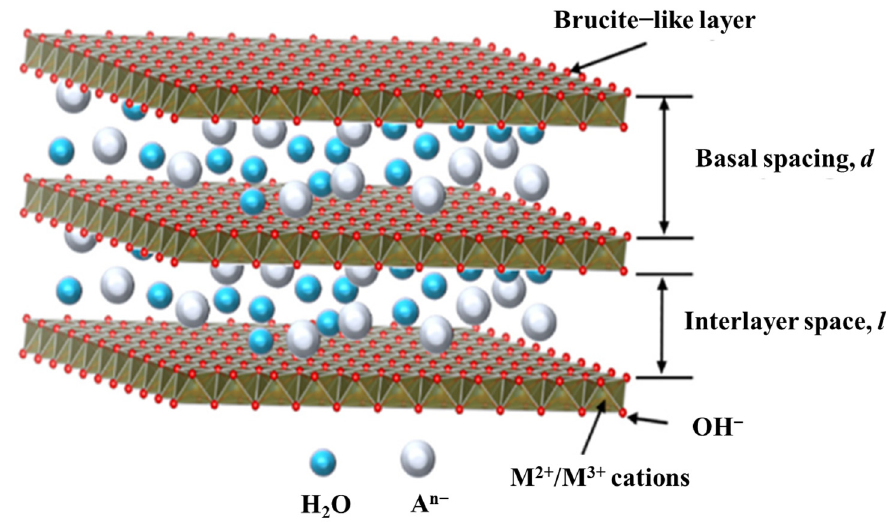
Figure 2. Schematic diagram of LDH structure [60].